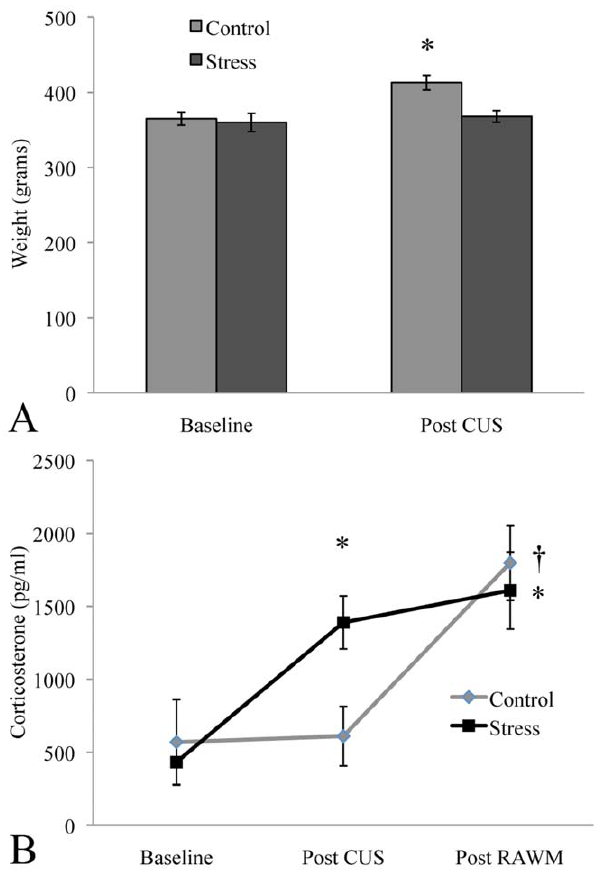
Figure 1. CUS and learning were both stressful. Animals that underwent CUS did not gain weight over the 2-week period of stressor exposure, whereas control animals did (A). Exposure to the CUS paradigm raised corticosterone levels, as did learning in the RAWM (B). Note, however, that learning did not further elevate corticosterone in stressed animals. *significantly different from baseline, { significantly different from Post CUS control.